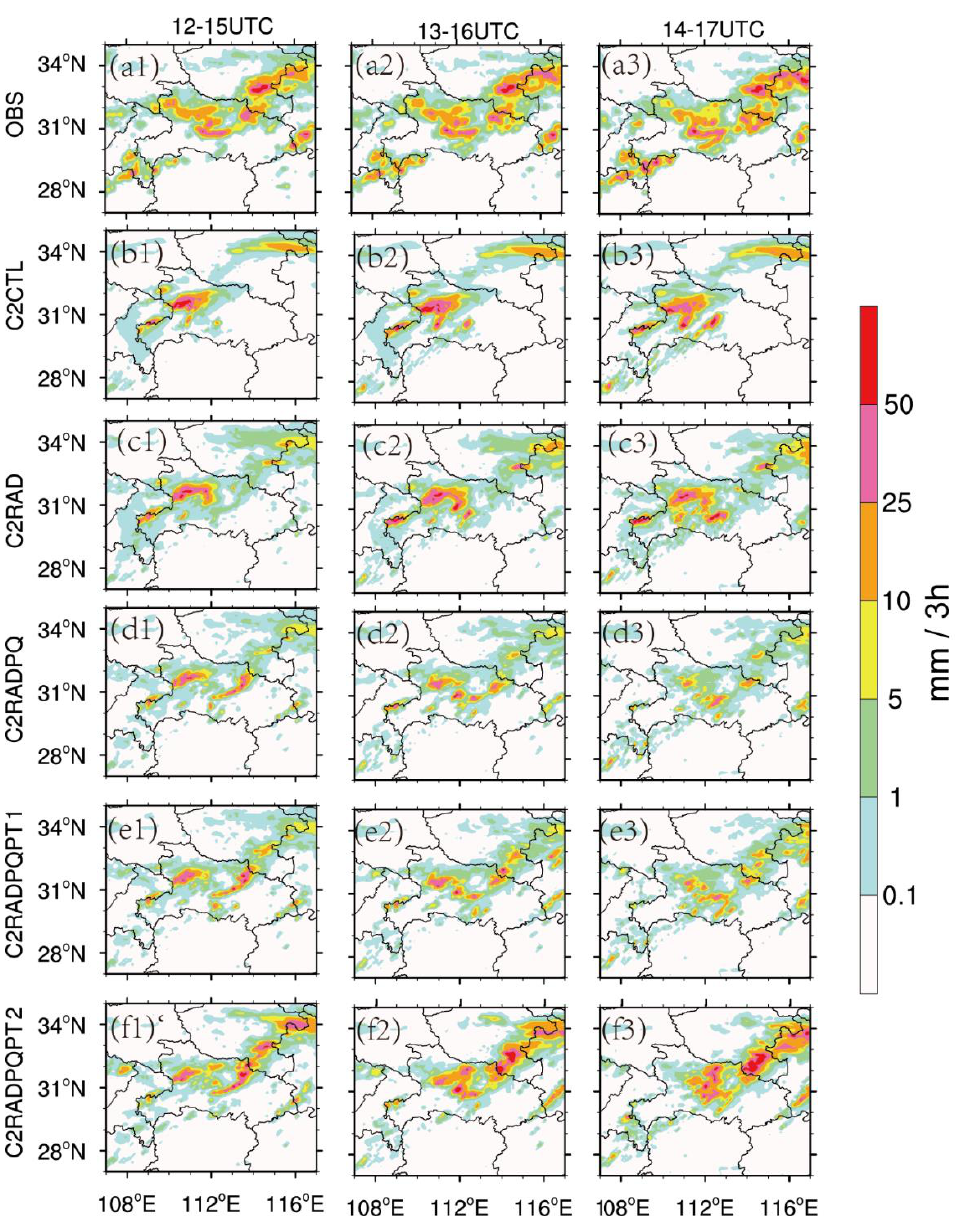
Figure 14. Same as Figure 9, but for 4 July, 2018.